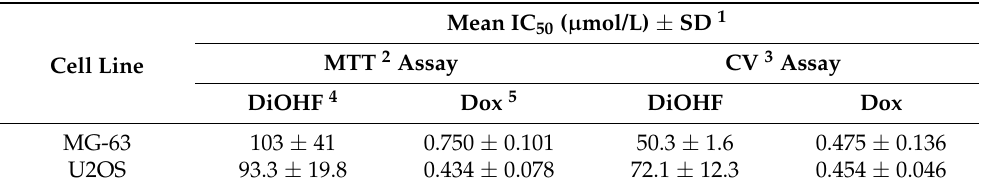
Table 1. IC 50 values ( µ mol/L ± SD) of DiOHF and Dox. Cells were exposed to DiOHF or Dox for 48 h and IC 50 values were determined following MTT and CV